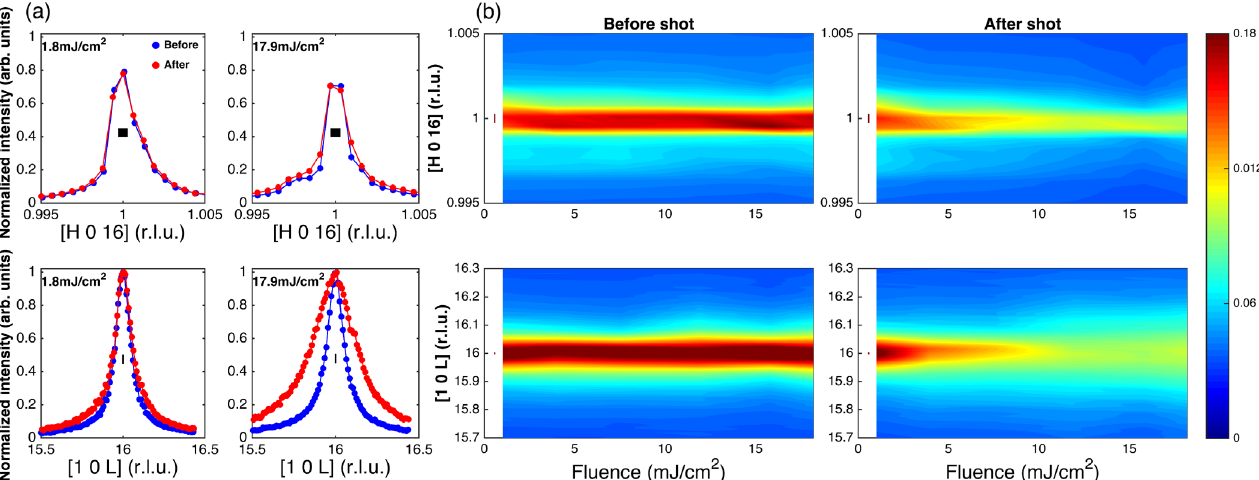
FIG. 2. Evolution of the magnetic ordering upon laser stimulation. (a) Comparison of the H (in-plane) and L (interplane) scans before and after single-pulse-laser pumping. The horizontal bars are our instrumental resolution. Scans are normalized to the peak height determined from L scans to emphasize the variation in the peak widths. (b) Fluence-dependent evolution of the H and L